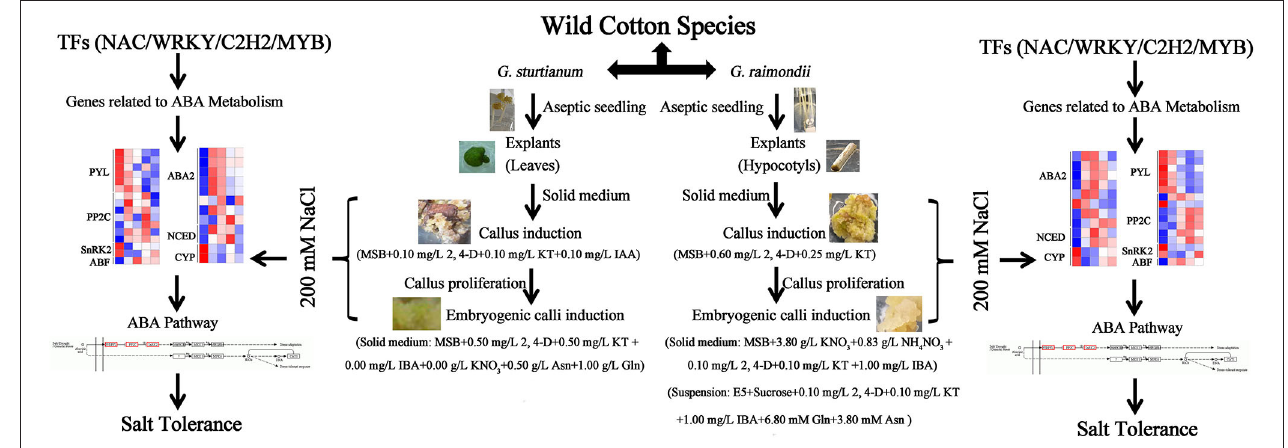
FIGURE 6 | The mode of embryogenic callus induction and salt tolerance of two wild cotton species G. sturtianum and G. raimondii .